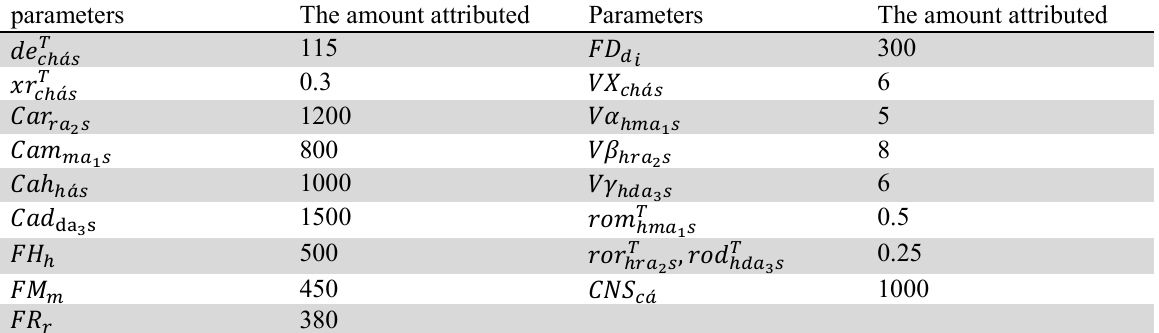
General information of the test problem to be solved by GAMS software Number of problem